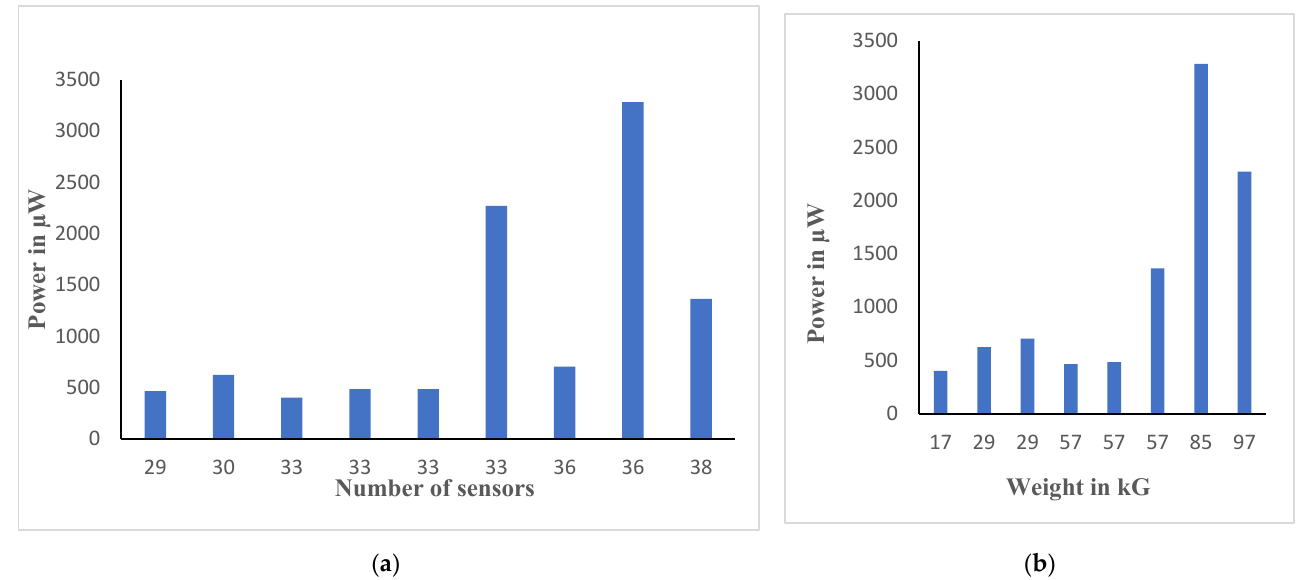
Figure 7. Predicted power analysis using varying quantities of ( a ) sensors and ( b ) weights of the subject.